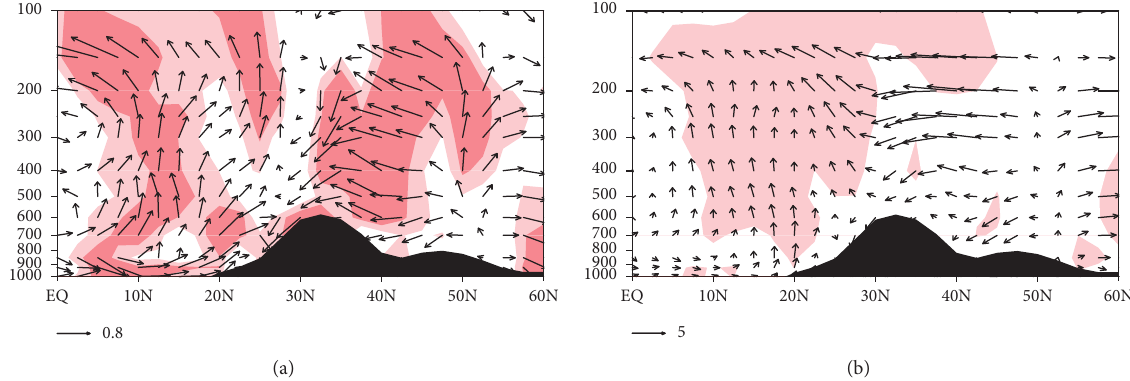
Figure 9: (a) Simultaneous correlation between I ° E. (b) Composite W and the meridional vertical circulation averaged over 90–100 anomalies of the meridional vertical circulation averaged over 90–100 ° E between the high- I W and low- I W years. The dark (light) shading in (a) indicates the correlation coefficients significant at the 99% (95%) confidence level. The shading in (b) indicates the meridional vertical circulation anomalies significant at the 95% confidence